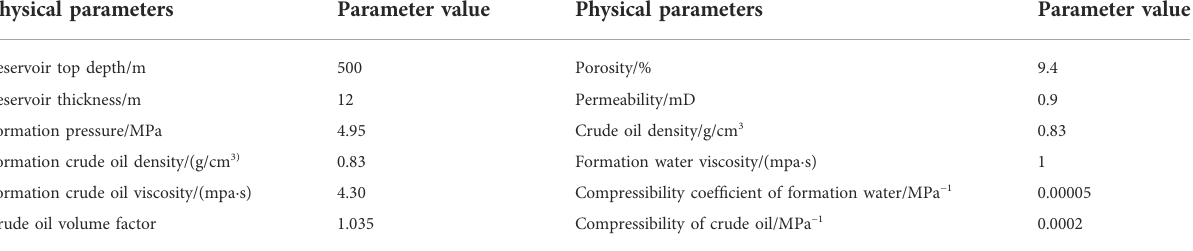
TABLE 5 Setting of simulation parameters.